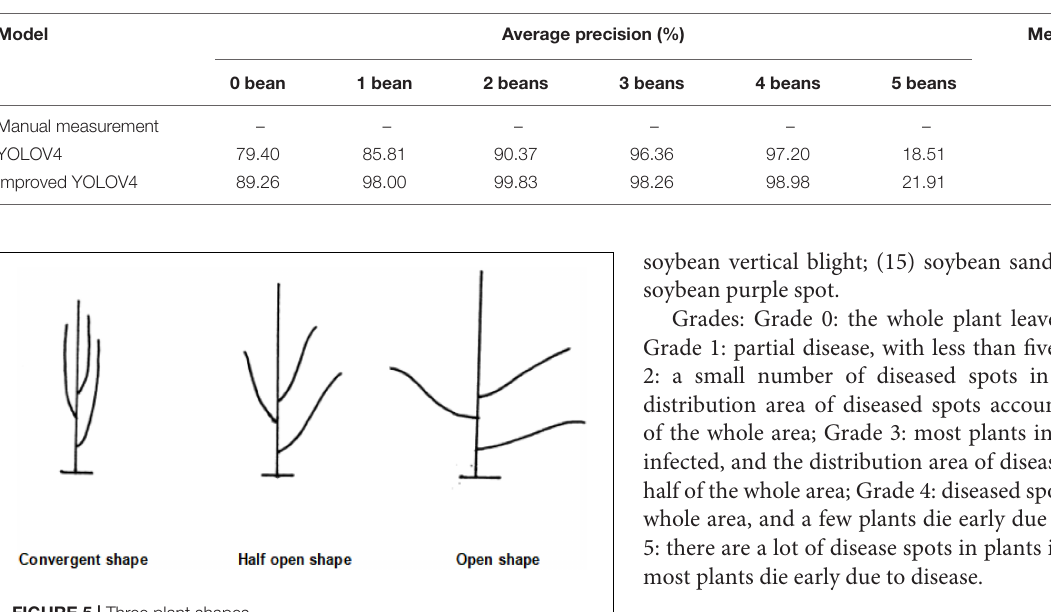
TABLE 2 | Model evaluation index.